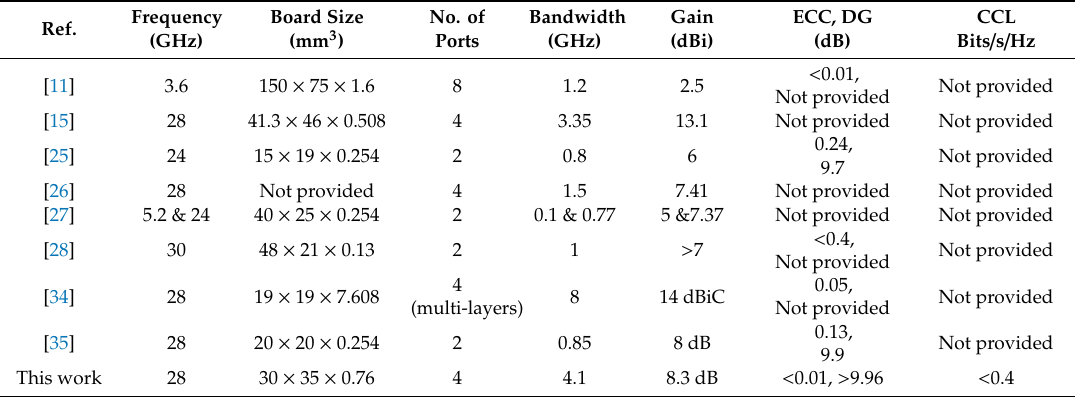
Table 4. Performance comparison with recent state of the art in the literature.